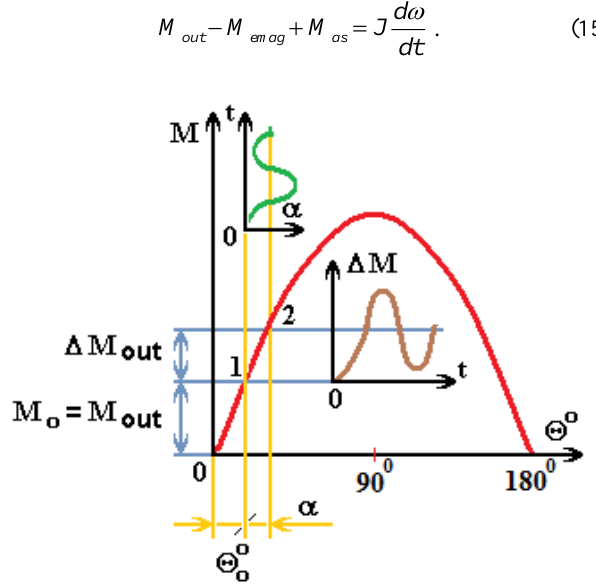
Fig. 4. Angular characteristic of the synchronous